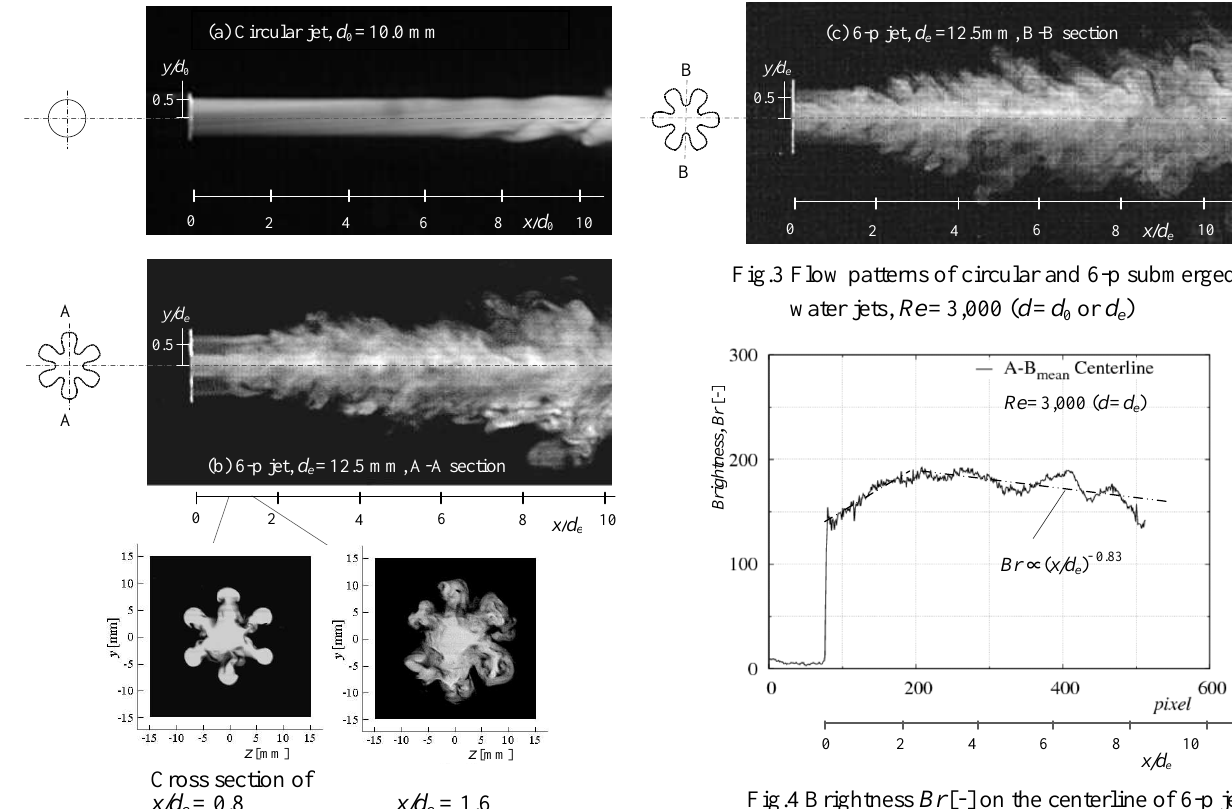
Fig.4 Brightness Br [-] on the centerline of 6-p jet